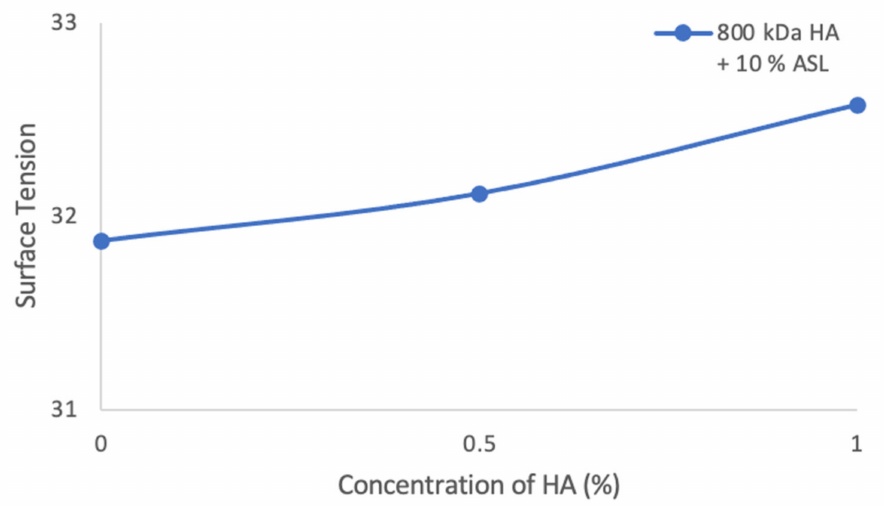
Figure 8. Effect of HA concentration and ASL on surface tension.